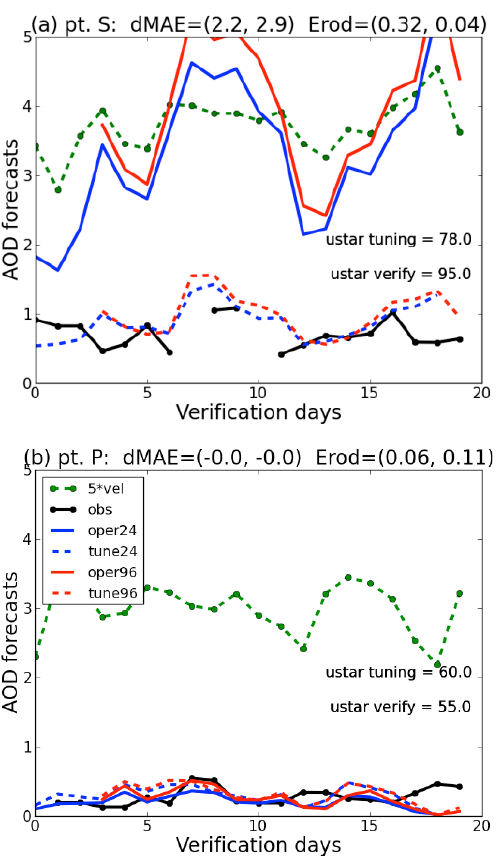
Fig. 13. AOD verifications at grid points S and P in Fig. 12. Legend Figure 13 : AOD verifications at grid points S and P in Figure 12. Legend in in (b) applies to (a) panel (b) applies to panel (a).